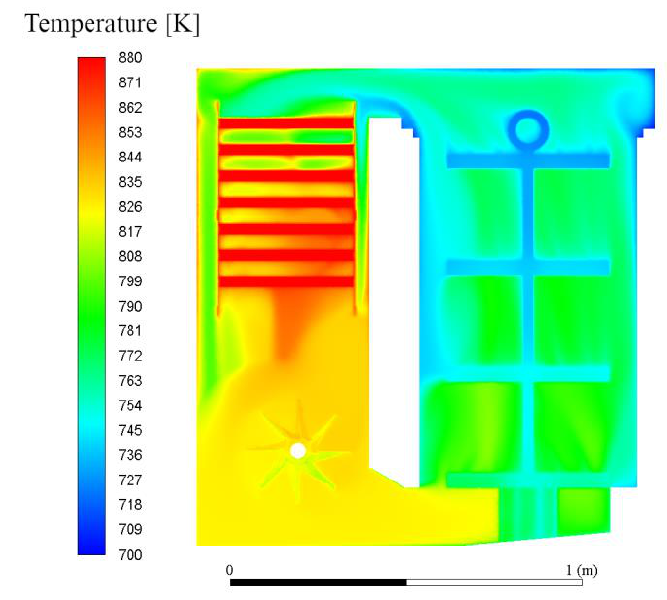
Figure 11. Temperature distribution of the baseline operation with a charging basket.